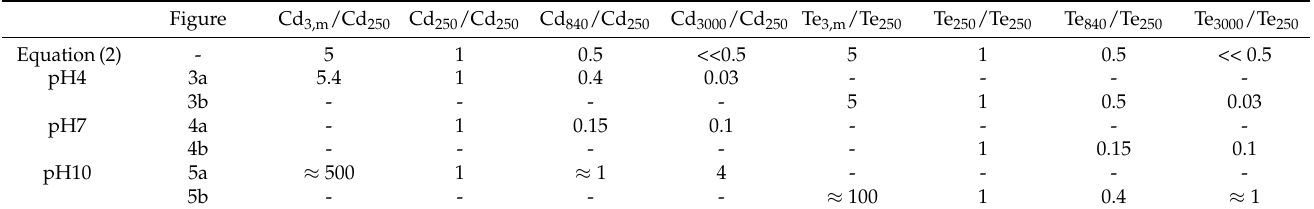
Figure 6. Maximum values of the data from Figures 3–5 after t = 83 days, respectively t = 56 days. For acidic conditions (pH4) more Cd than Te is found in the solution, for neutral conditions (pH7) the relative amount of Cd and Te in solution is about the same, whereas for alkaline conditions (pH10) the tendency is less Cd than Te in the solution. The smaller the particles, the more Cd and Te is found in the solutions. Table 1. Relative ratios of the dilution rates for the different CdTe powders and the milled module pieces compared to the relative surface to volume ratio from Equation (2). For pH4 the elution of Cd as well as for Te is in good agreement with Equation (2). For pH7 there is a noticeable and for pH10 a strong deviation from Equation (2), in particular if one compares the leached module pieces with the powders for pH10. For the powders, the elution is much more suppressed, probably via a chemical passivation of the surface of the powder